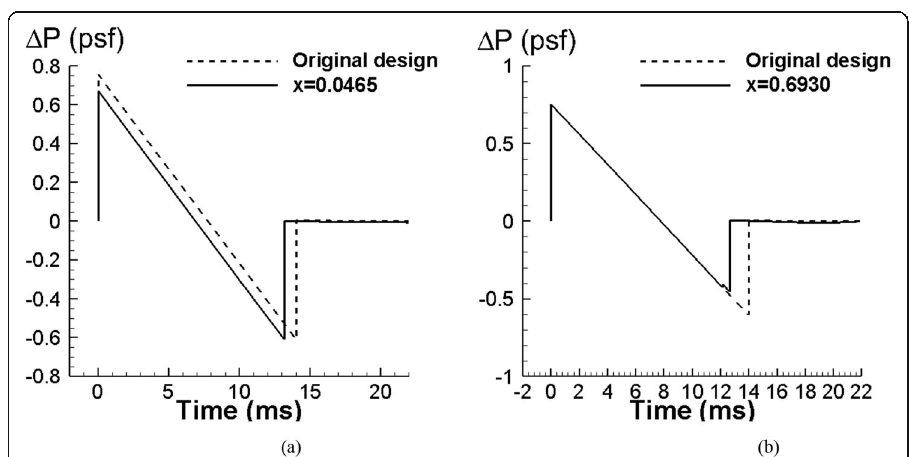
Fig. 8 Ground boom signatures of the baseline and optimized NACA0008 airfoil a with a suction slot at the optimal location and b with an injection slot at the optimal